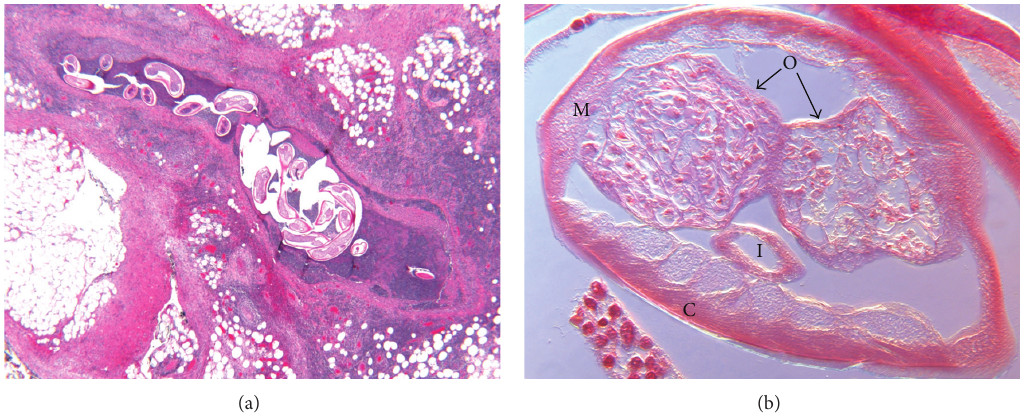
Figure 2: (a) Filariasis, lymphatic channel in perinodal adipose tissue. The lymphatic channel contains ensheathed helminthic structures consistent with an adult female Wuchereria bancrofti consisting of an external cuticle and a coelomic cavity containing paired ovaries and intestinal structures. The lymphatic channel shows perivascular fibrosis and contains within its both wall and lumen an inflammatory infiltrate composed primarily of lymphocytes and histiocytes. Eosinophils are rare, but individual cells cannot be discerned at this power. The inflammatory infiltrate and fibrous tissue extend into the perilymphatic adipose tissue (hematoxylin and eosin, × 25). (b) Wuchereria bancrofti . The external cuticle (C) appears focally striate, the muscle (M), intestine (I), and paired ovaries (O) are clearly visible, and the ovaries do not contain microfilariae, indicating a nongravid female (H&E, × 787, interference contrast with vertical image